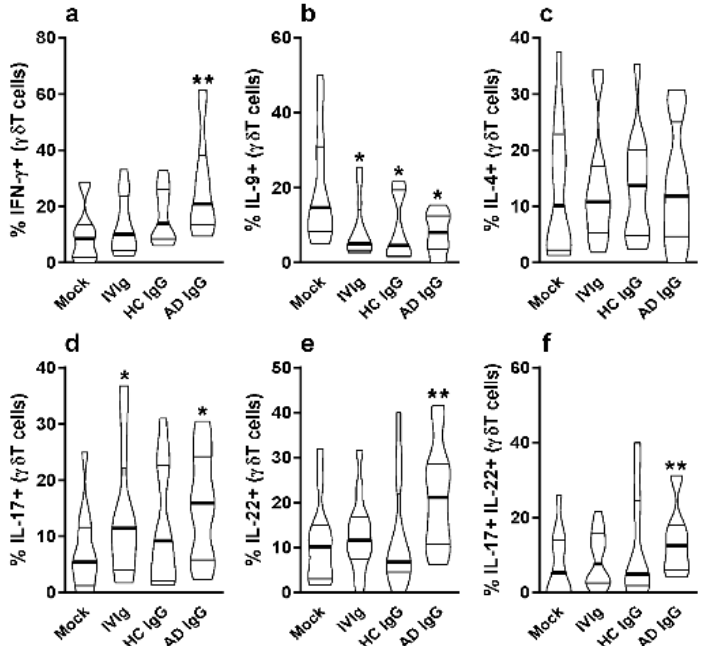
Figure 2. Effect of purified adult AD IgG on the cytokine production of infant nonatopic intra- thymic γδ T cells. Thymocytes from children under 7 days old ( n = 12) were evaluated after 6 days in culture in RPMI medium supplemented with FCS in the absence (mock) or presence of 100 µ g/mL of commercially used purified IgG (IVIg) or IgG purified from health controls (HC IgG) or IgG purified from adult AD patients (AD IgG). Flow cytometry was used to determine the intracellular production of IFN- γ ( a ), IL-9 ( b ), IL-4 ( c ), IL-17 ( d ), IL-22 ( e ) or the coproduction of IL-17 and IL-22 ( f ) were evaluated in γδ T (CD3+ γδ TCR+) cells. Violin plots shows the distribution of values from lowest to highest, with thick lines representing quartiles and bold lines representing the mean. * p ≤ 0.05 when compared to the mock condition. ** p ≤ 0.05 when compared to the Mock, IVIg, and HC IgG conditions.